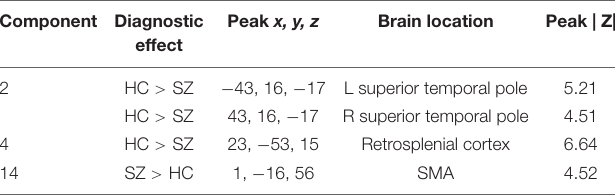
TABLE 3 | Brain labels and peak scores for concentration ICA components showing diagnostic differences. Component Diagnostic